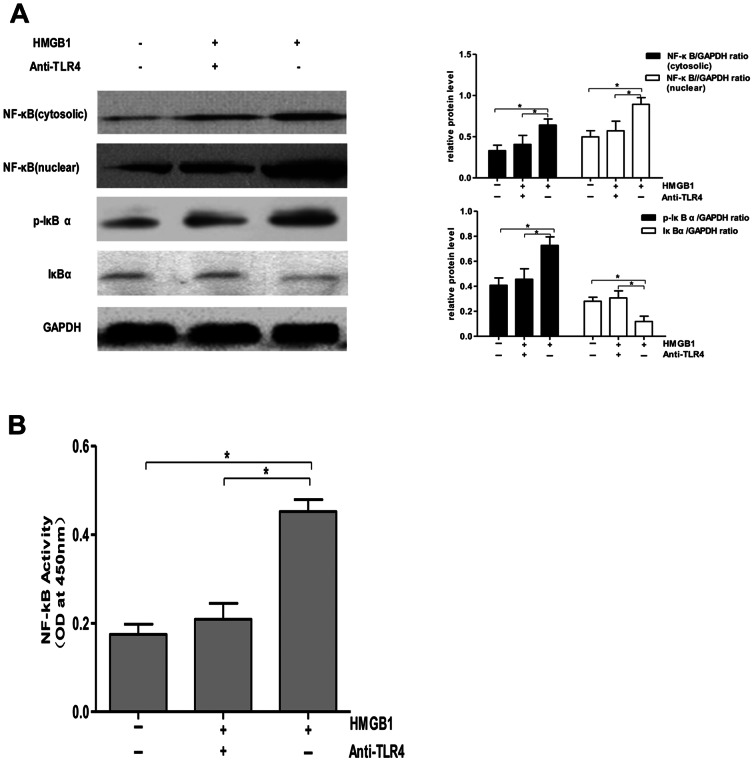
TLR4 took part in HMGB1-induced activation of NF-κB. A:With or no pretreatment of TLR4 neutralizing antibody, HSCs were stimulated by HMGB1 for 24 h to be analyzed the protein levels of NF-kB, phospho-IkBα and IkBα by western blot. Compared to the HMGB1 stimulation, TLR-4 neutralizing antibody pretreatment resulted in a decrease in NF-kB protein level as well as in phospho-IkBα level, while a concomitant increase in the cytosolic IkBα protein level. *p<0.05, compared with 100 ng/ml HMGB1. B: Effect of HMGB1 with or without TLR4 neutralizing antibody on NF-kB/p65 activity determined by an ELISA-based assay as described in Materials and Methods. *p<0.05, compared with 100 ng/ml HMGB1.